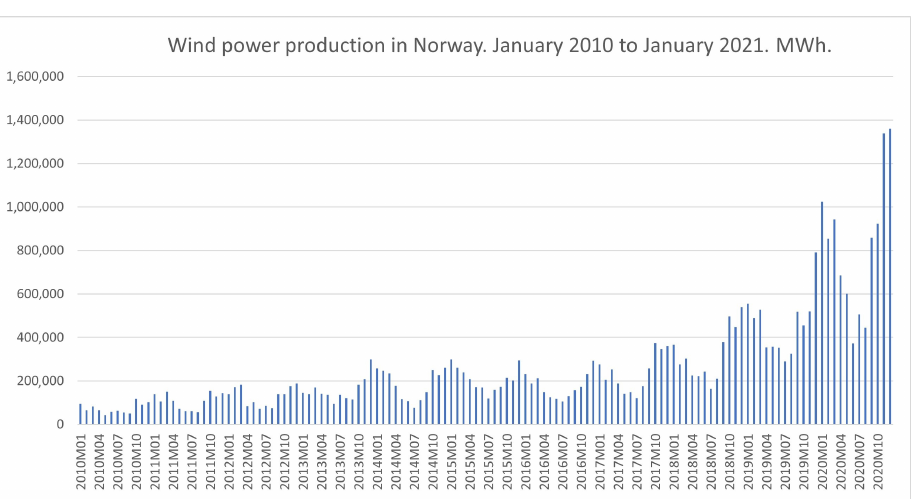
Figure 11. Monthly wind power production in Norway from January 2010 to January 2021. Based on figures from Statistics Norway.